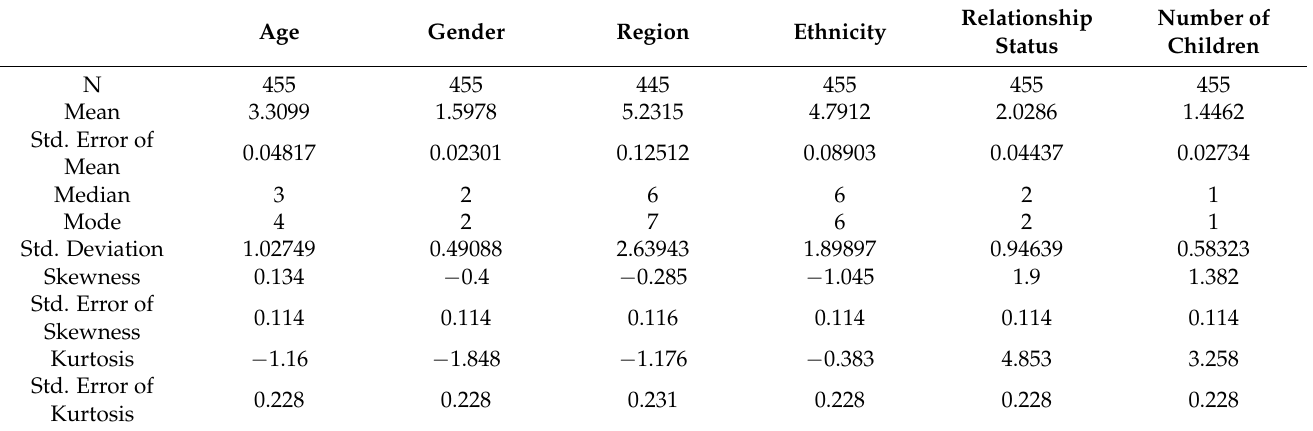
Table 11. Descriptive